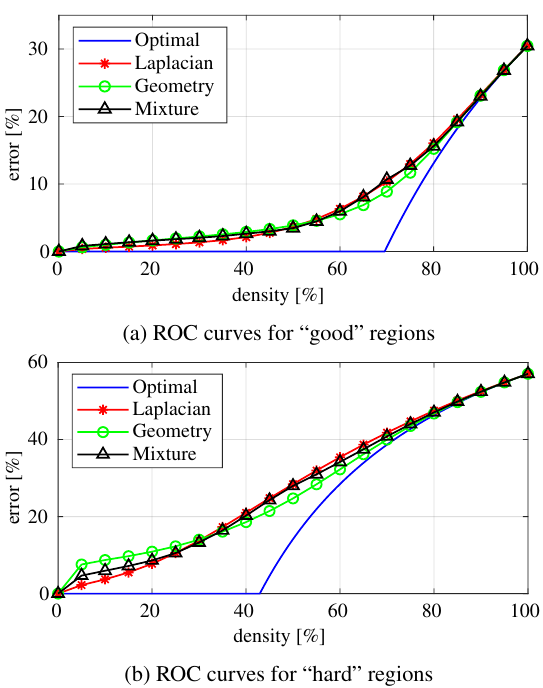
Figure 2. ROC curves for the first 100 images of the KITTI 2015 dataset and Census-based block matching. The closer the curve of an uncertainty model reaches the optimal curve, the higher the accuracy. The areas under these curves correspond to the AUC values in Table